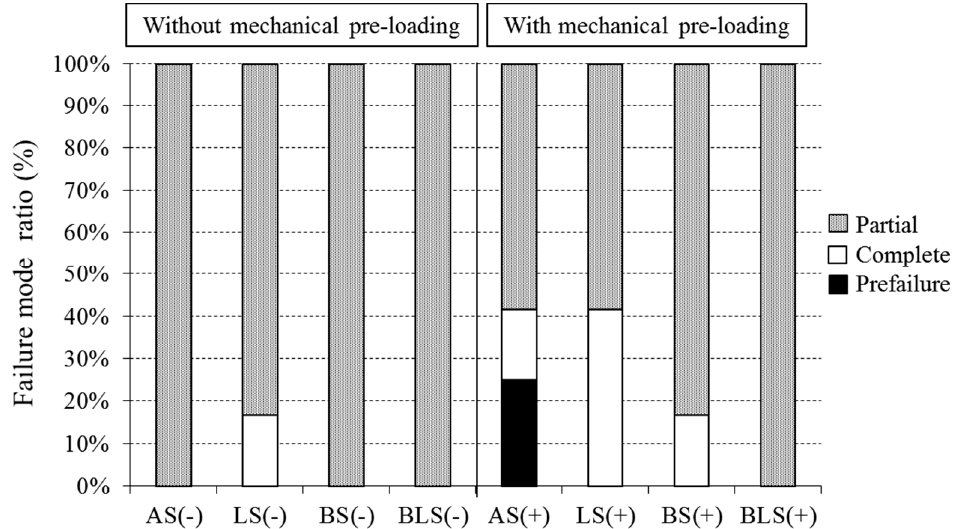
Figure 4. The distribution of failure mode ratio of each experimental group. Details of experimental groups are shown in Table 1.